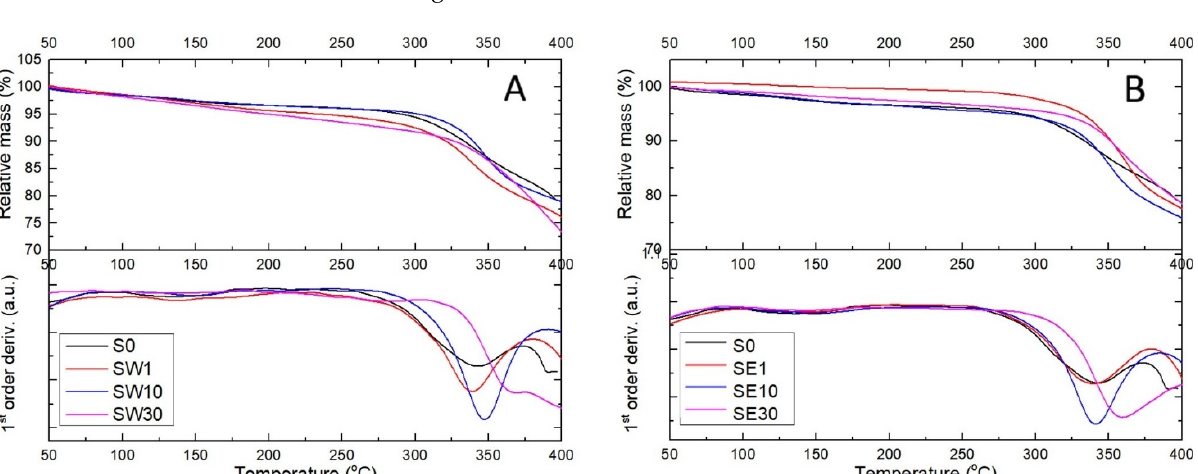
Figure 5. Thermogravimetric analysis of RF-modified membranes using water ( A ) and an ethanol–water mixture ( B ) as the solvents in the impregnation process performed in air at a heating rate of 10 °C/min.